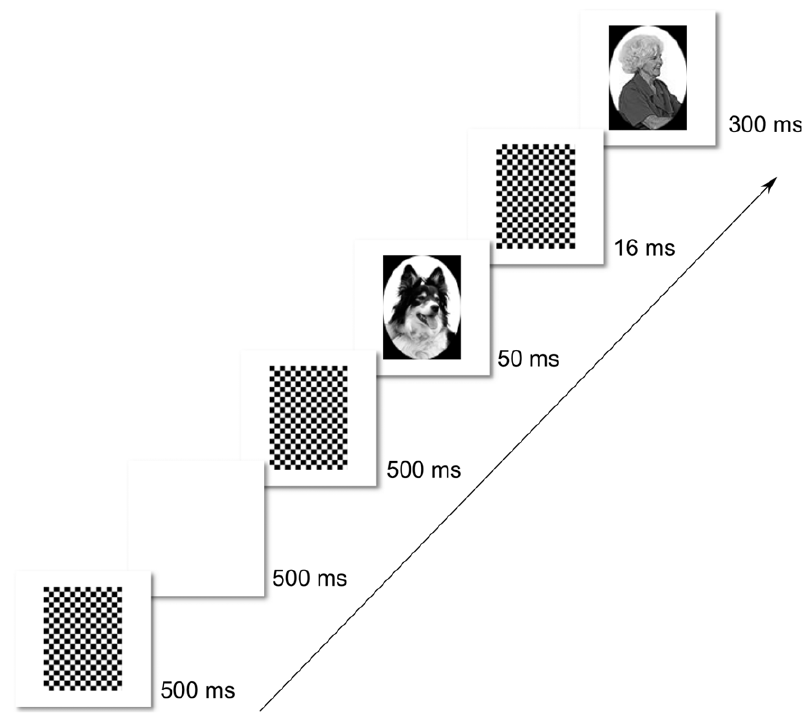
Figure 3. Trial Structure in Experiment 1. Here we depict an incongruent trial, in which a Person target follows the Animal prime stimulus. The forward and backward masks are complementary checkerboard patterns. The prime duration is 50 ms; the target duration is 300 ms.